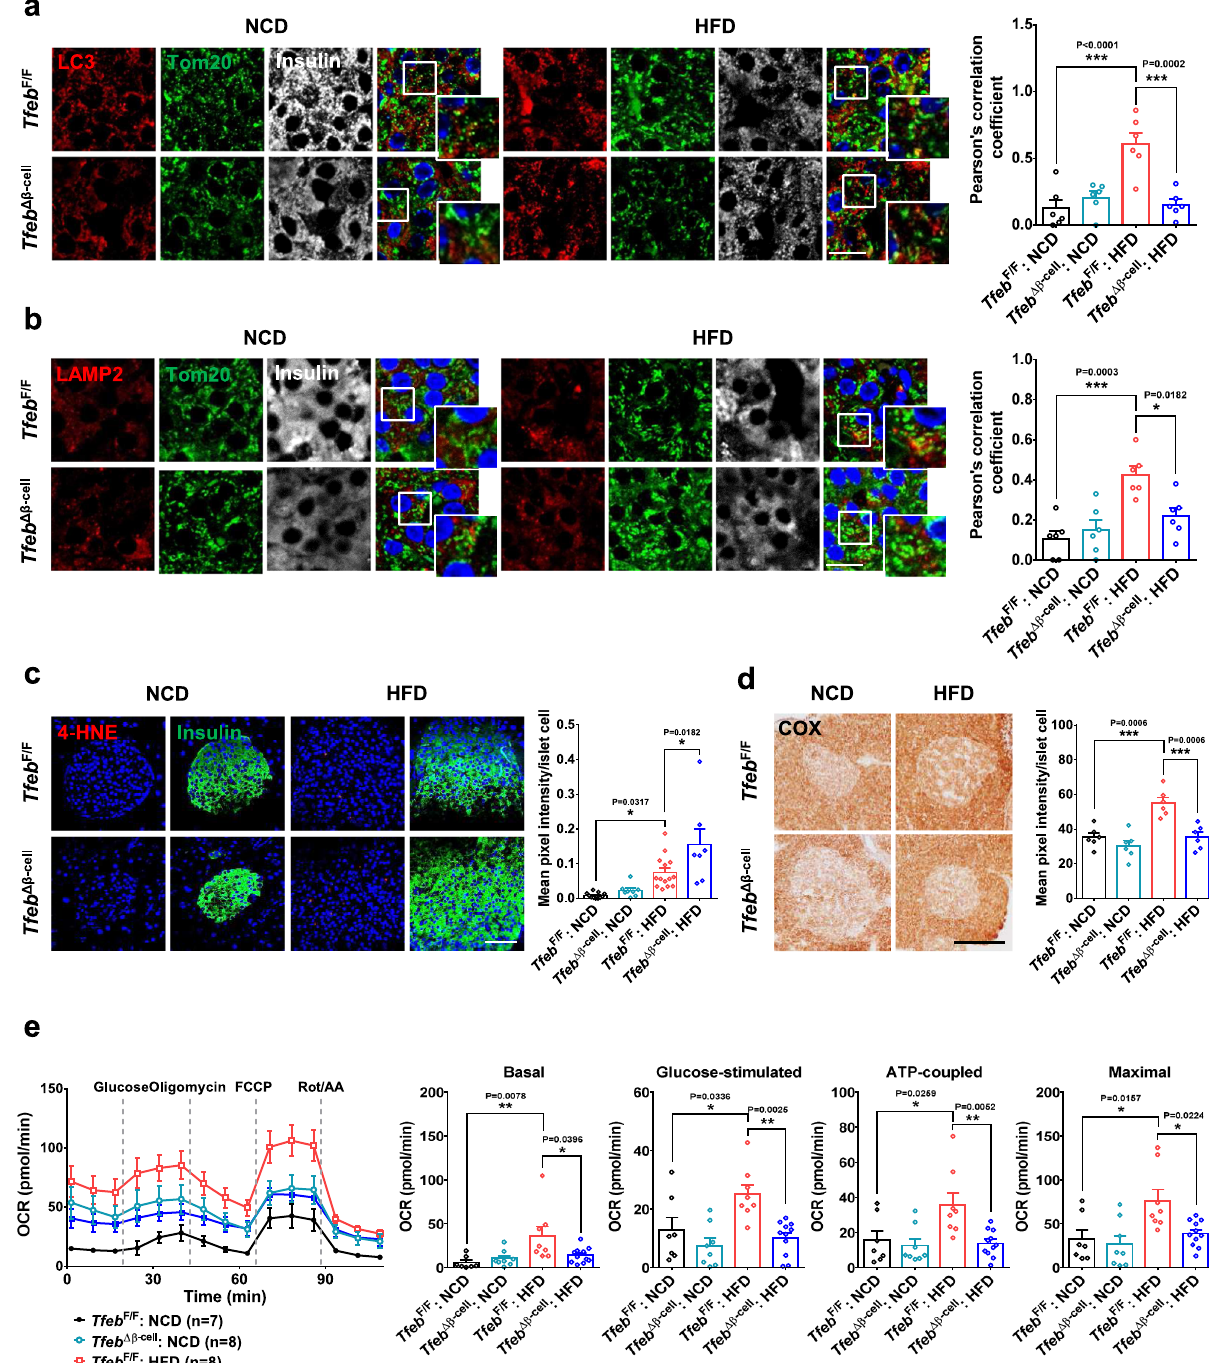
expression by ex vivo rotenone or O/A treatment were signi fi cantly reduced by β -cell Tfeb KO (Fig. 6d), supporting that TFEB-dependent induction of crucial mitophagy receptors and lysosomal genes by mitochondrial or metabolic stress facilitates mitophagy.